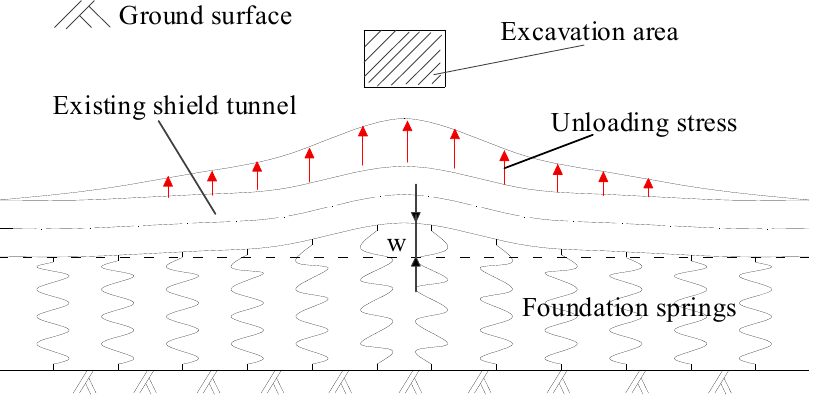
Figure 1. Single-sided elastic foundation beam model for shallow tunnel.